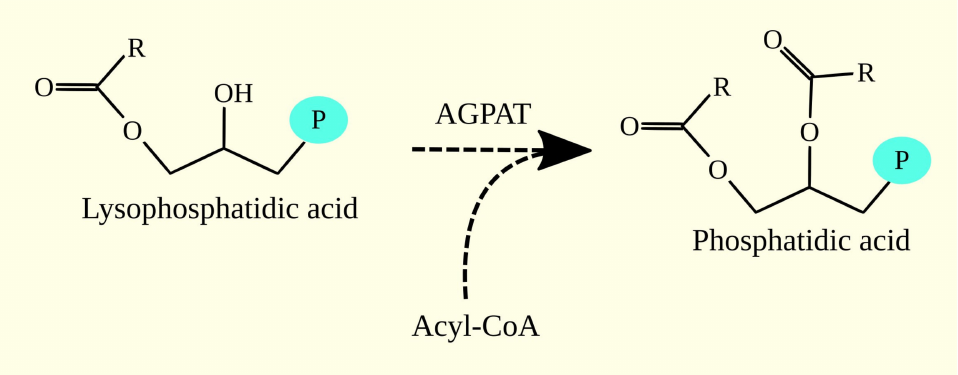
Figure 3. AGPAT enzymes participate in the biosynthesis of phosphatidic acid from lysophosphatidic acid. They require fatty acyl-CoA to catalyze this